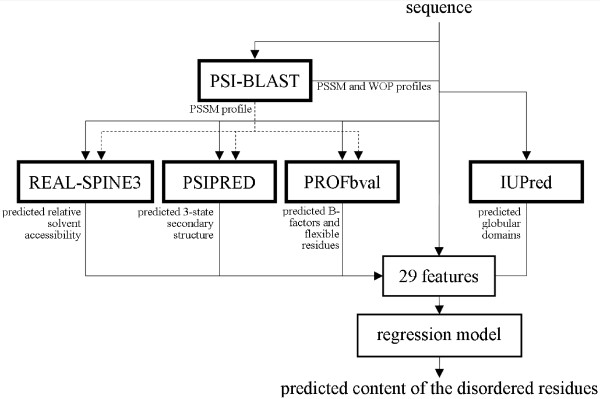
Architecture of the DisCon predictor.